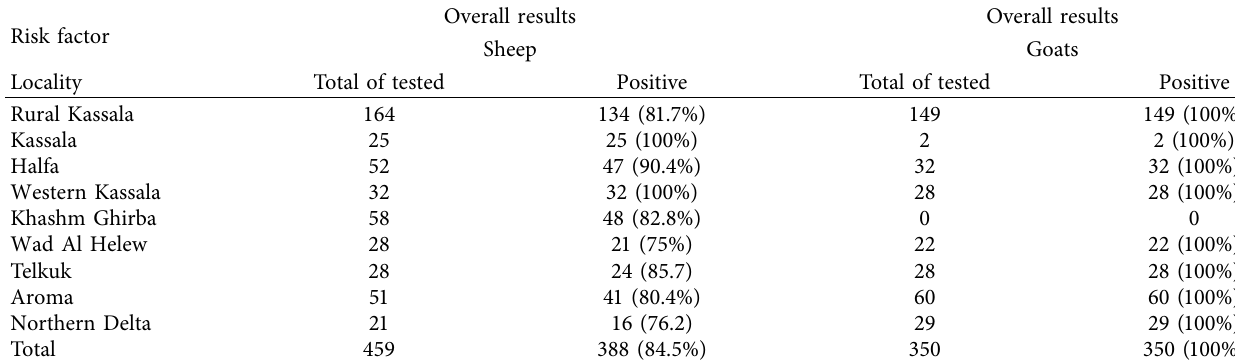
Table 2: Influence of the locality risk factor on overall seroprevalence of BTV in Kassala state.